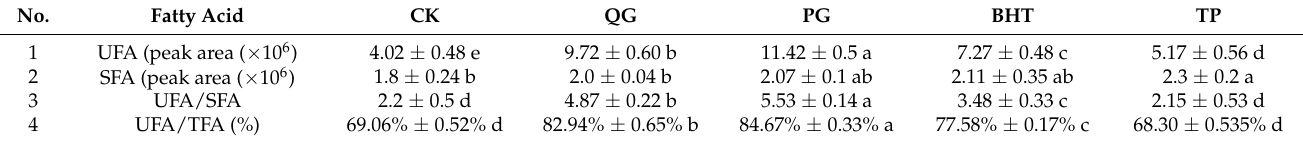
Table 4. Saturated fatty acids (SFAs), unsaturated fatty acids (UFAs), unsaturated and saturated fatty acids (UFA/SFA) ratio, unsaturated and total fatty acids (UFA/TFA) of analysed soybean oils. Results are reported as peak area percent ± uncertainty expressed as the half-width of the 95% confidence